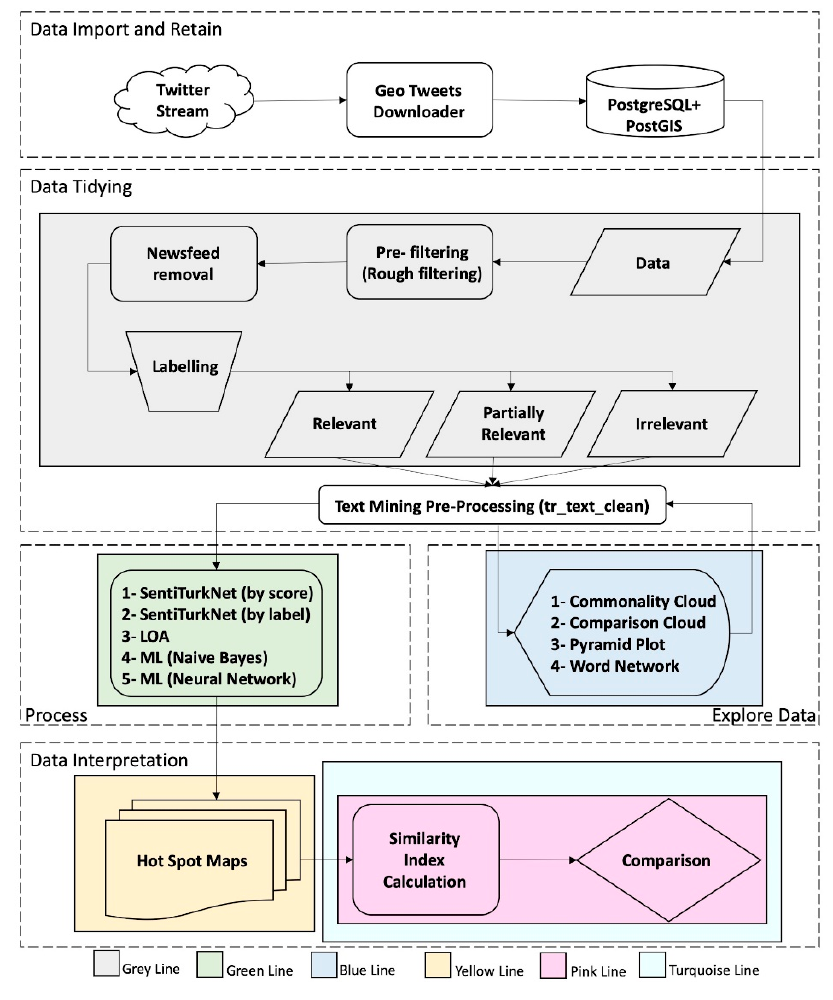
Figure 1. Data workflow.